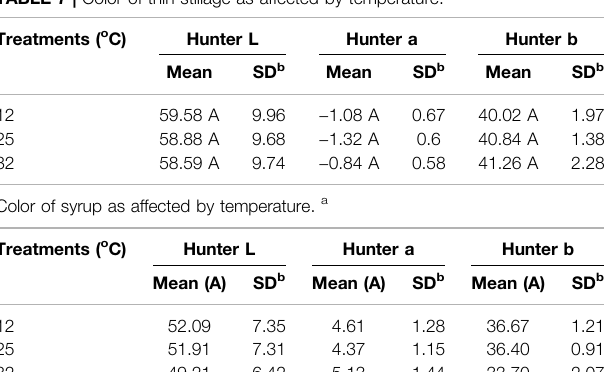
TABLE 7 | Color of thin stillage as affected by temperature. a